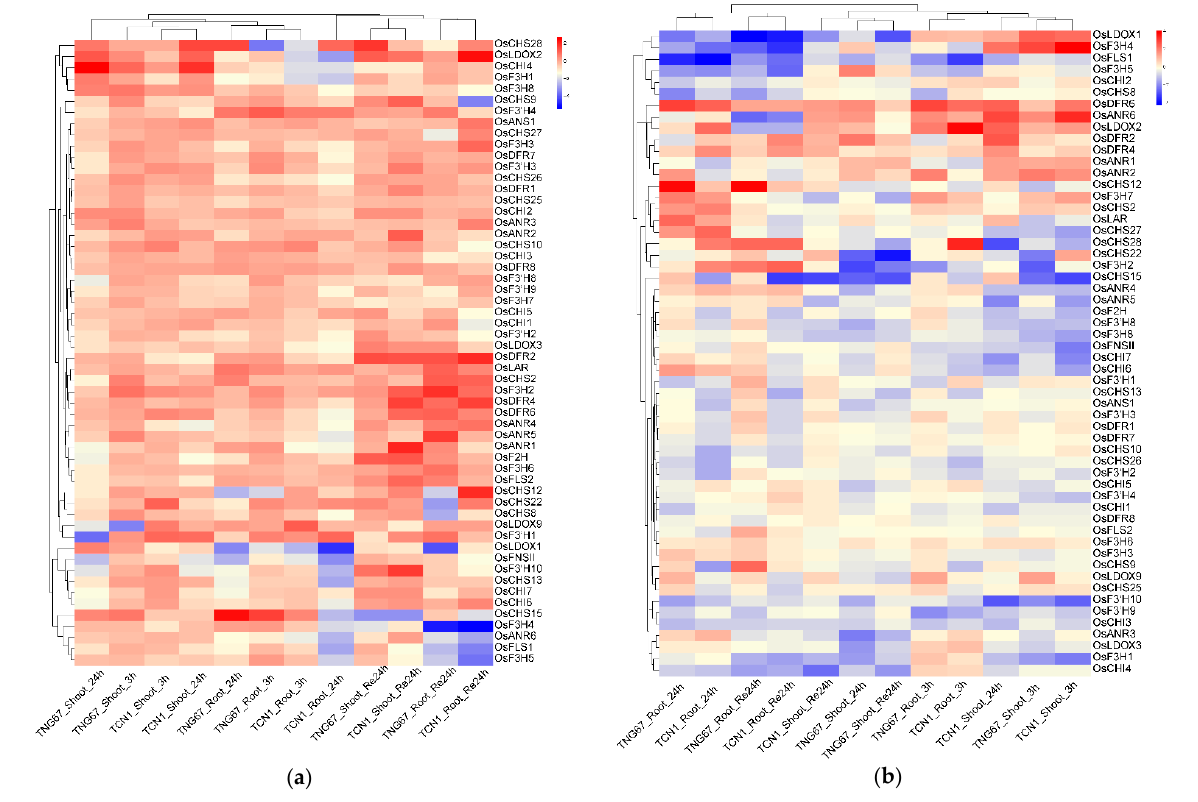
Figure 5. Expression profiles of 85 flavonoid-related genes under cold ( a ) and salt ( b ) stress: TNG67 and TCN1 represent two rice cultivars; 3 h, 24 h and Re24 indicates 3 h after treatment, 24 h after treatment and after a 24 h recovery, respectively. The values were calculated by log 2 foldchange based on the conditions, with significant results for the t -test ( p -value < 0.05) after normalization to the control; red indicates upregulation and blue indicates downregulation.